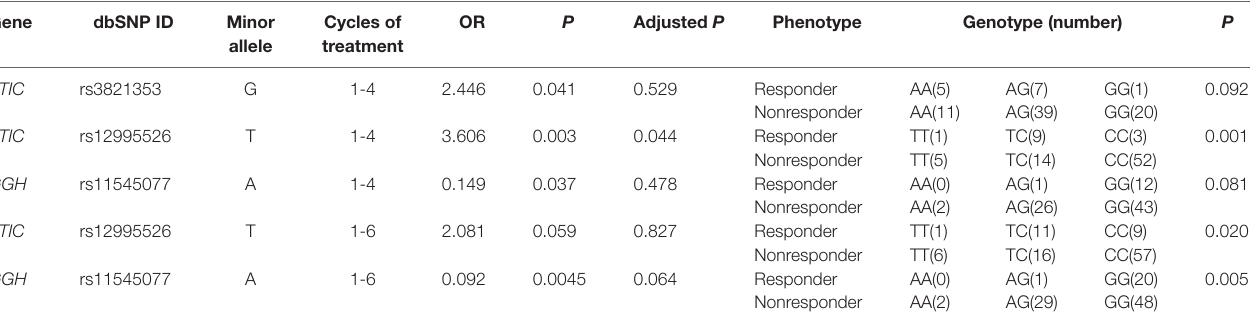
TABLE 3 | Summary of association analysis between SNP site and therapeutic effects in pemetrexed-treated patients